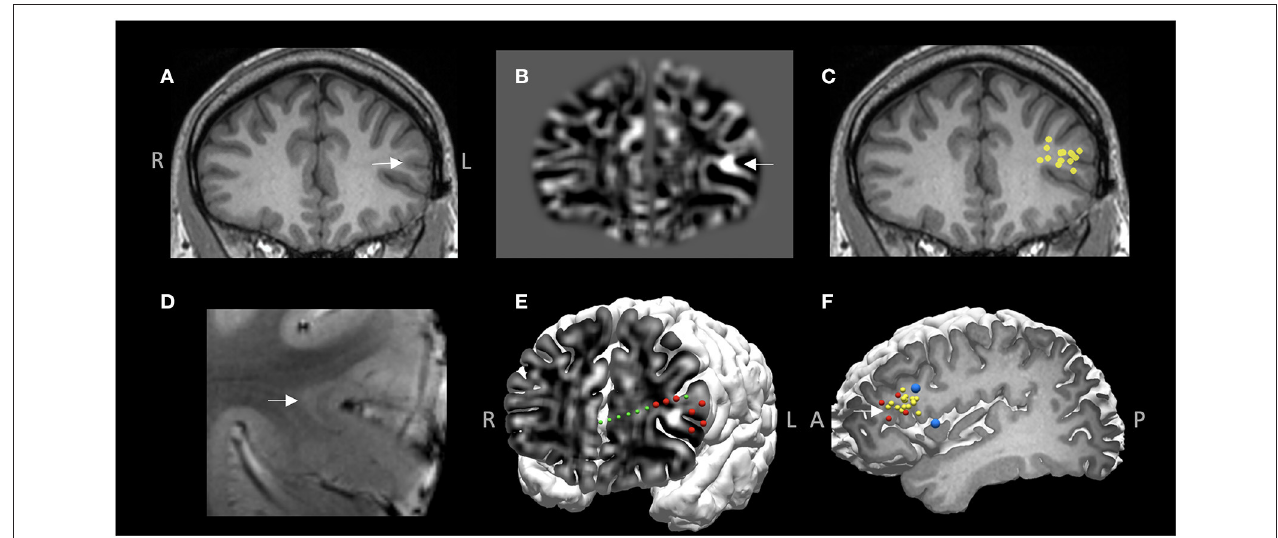
FIGURE 7 | MMII findings in Case 1. (A) 3T T1-weighted MRI on coronal plane. (B) Z-score map of gray-white matter junction from MAP processing based on the 3T T1-weighted images, shown on the same coronal plane as (A) , demonstrating a subtle structural abnormality with gray-white blurring, likely focal cortical dysplasia (FCD). (C) A tight MEG dipole cluster shown on the same coronal plane as (A,B) , illustrating the MEG cluster overlapped well with the subtle structural abnormality. (D) 7T T2*-weighted GRE image corroborating the finding of a subtle FCD lesion with transmantle sign. (E) 3D view of ictal onset ICEEG electrode contacts (red spheres), both on the depth electrode (green spheres) and the subdural grid (for best visualization, only the onset electrode contacts are shown, not all the implanted grids), “sandwiching” the subtle structural abnormality. z-score map of gray-white matter junction from MAP processing is fused with the cortical surface to reveal the 2D-3D spatial relationship of the subtle lesion and the overlaying cortex as well as the ICEEG findings. (F) The tight MEG cluster (yellow spheres), ictal onset (red spheres) and language regions shown on cortical stimulation (blue spheres). White arrow indicates the location of the subtle structural abnormality in (A,B,D,F) . This patient underwent a focused left frontal lesionectomy, had no speech deficits postoperatively and remained seizure-free for 4 years at the most recent follow up. Histopathology showed FCD type